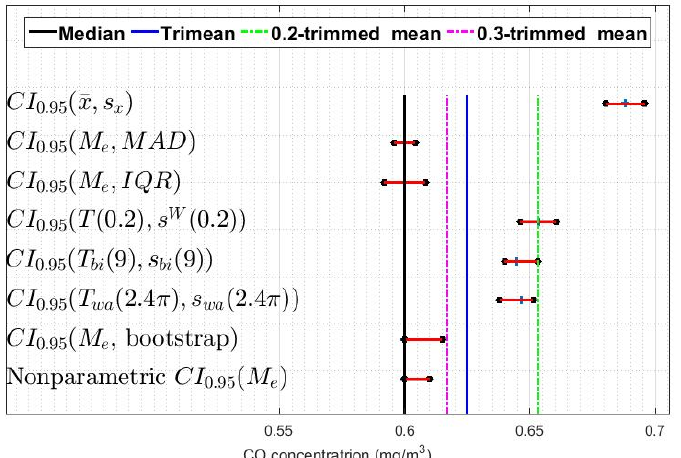
Figure 8. 95% confidence intervals ( CI 0.95 ) for X 5 ( 2012 ) : classic, nonparametric, bootstrap, and robust Figure 8. 95% confidence intervals ( (cid:1829)(cid:1835) (cid:2868).(cid:2877)(cid:2873) ) for (cid:1850) (cid:2873) (2012) : classic, nonparametric, bootstrap, and robust Figure 8. 95% confidence intervals ( (cid:1829)(cid:1835) (cid:2868).(cid:2877)(cid:2873) ) for (cid:1850) (cid:2873) (2012) : classic, nonparametric, bootstrap, and robust confidence intervals. Sensors 2020 , 20 , x FOR PEER REVIEW 13 of 23 confidence intervals. confidence intervals.